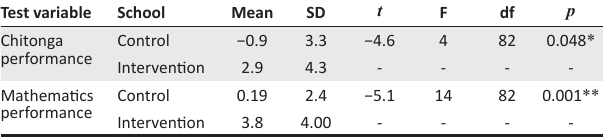
TABLE 4: Mean difference scores between the control and intervention schools in Mathematics and Chitonga.